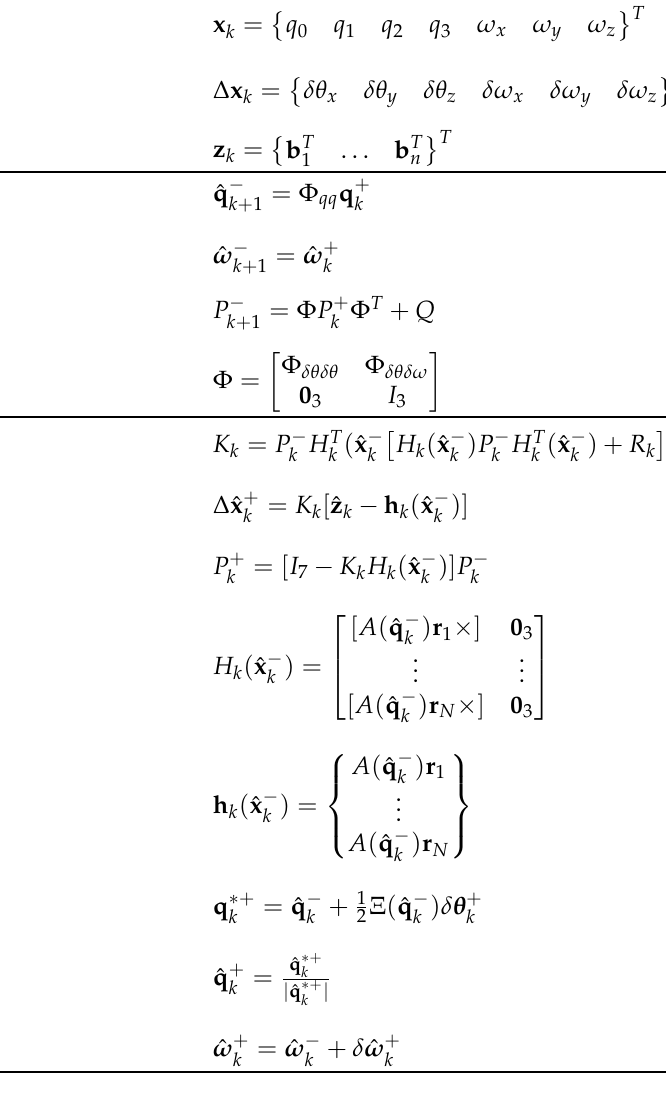
Table 2. EKF methodology for the Star Tracker using the state error